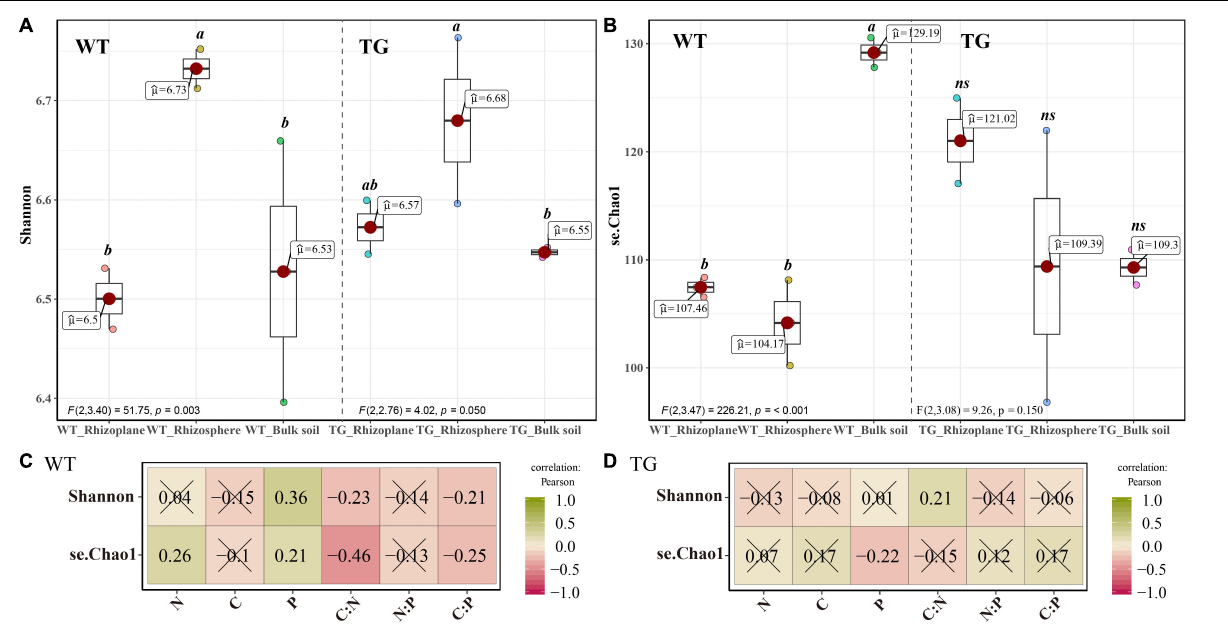
Frontiers in Microbiology |